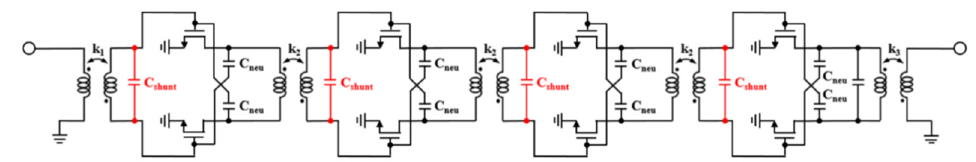
Figure 2. Schematic of the 4-stage cascade differential VGA.